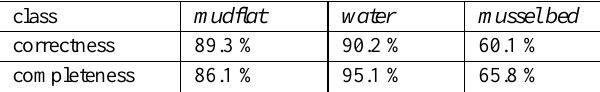
Table 1. Correctness and completeness rate for the three classes.